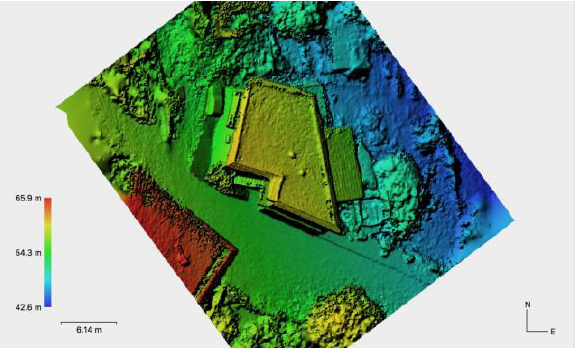
Figure 11. DEM of a building in Lacco Ameno